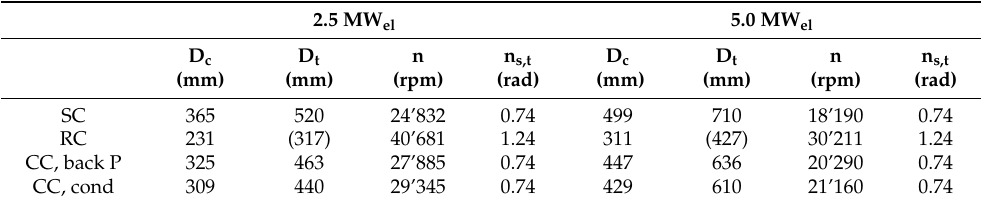
Table 7. Component maximum diameters and rotating speed; n s,c = 0.75 for all cases; CC components dimension and speed refer to type (A); CC type (B) has same dimensions of SC; RC turbine diameters were calculated assuming a radial turbine architecture.